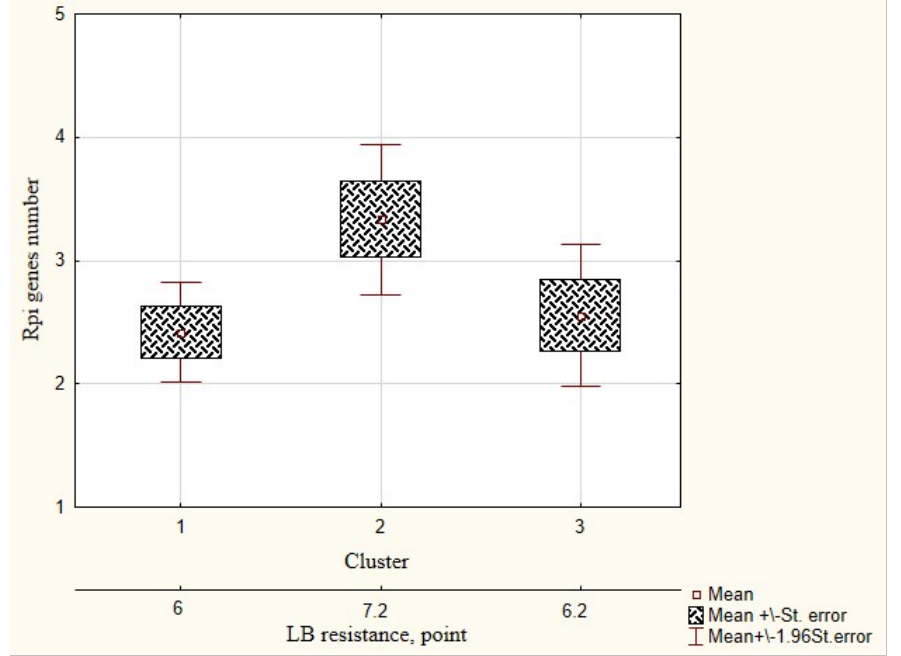
Figure 6. Predicted Rpi genes numbers (based on SCAR markers) in F1 clones from segregant clusters of different LB resistance.